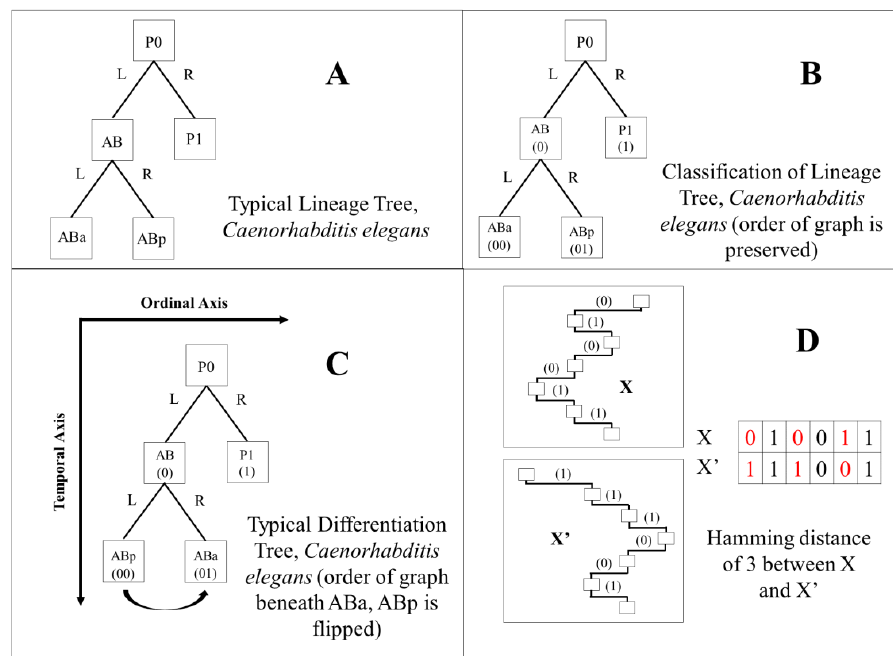
Figure 1. A demonstration of how binary codes produce different classifications of each cell in C. elegans embryos according to two different binary tree orderings. ( A ) Five nodes and their left/right (L/R) ordering in the C. elegans lineage tree; ( B ) a binary lineage code classification for these same nodes (cells) in the lineage tree, with 0 representing nodes that branch to the left, and 1 representing nodes that branch to the right; ( C ) the same five nodes as shown in A and B, but reordered to reflect their relative cell volumes, small daughter cells to the left (0) and large daughter cells to the right (1). This is reflected in their differentiation code classification; ( D ) a demonstration of how the Hamming distance metric is calculated for the “distance” between the lineage code and the differentiation code for a given cell (X and X’). Only the path in the tree is shown, from the root (top) to the given cell (bottom). Represented as a decimal number, the Hamming distance (see Methods) is the number of differences (or flipped bits) between X and X’ (labeled in red).